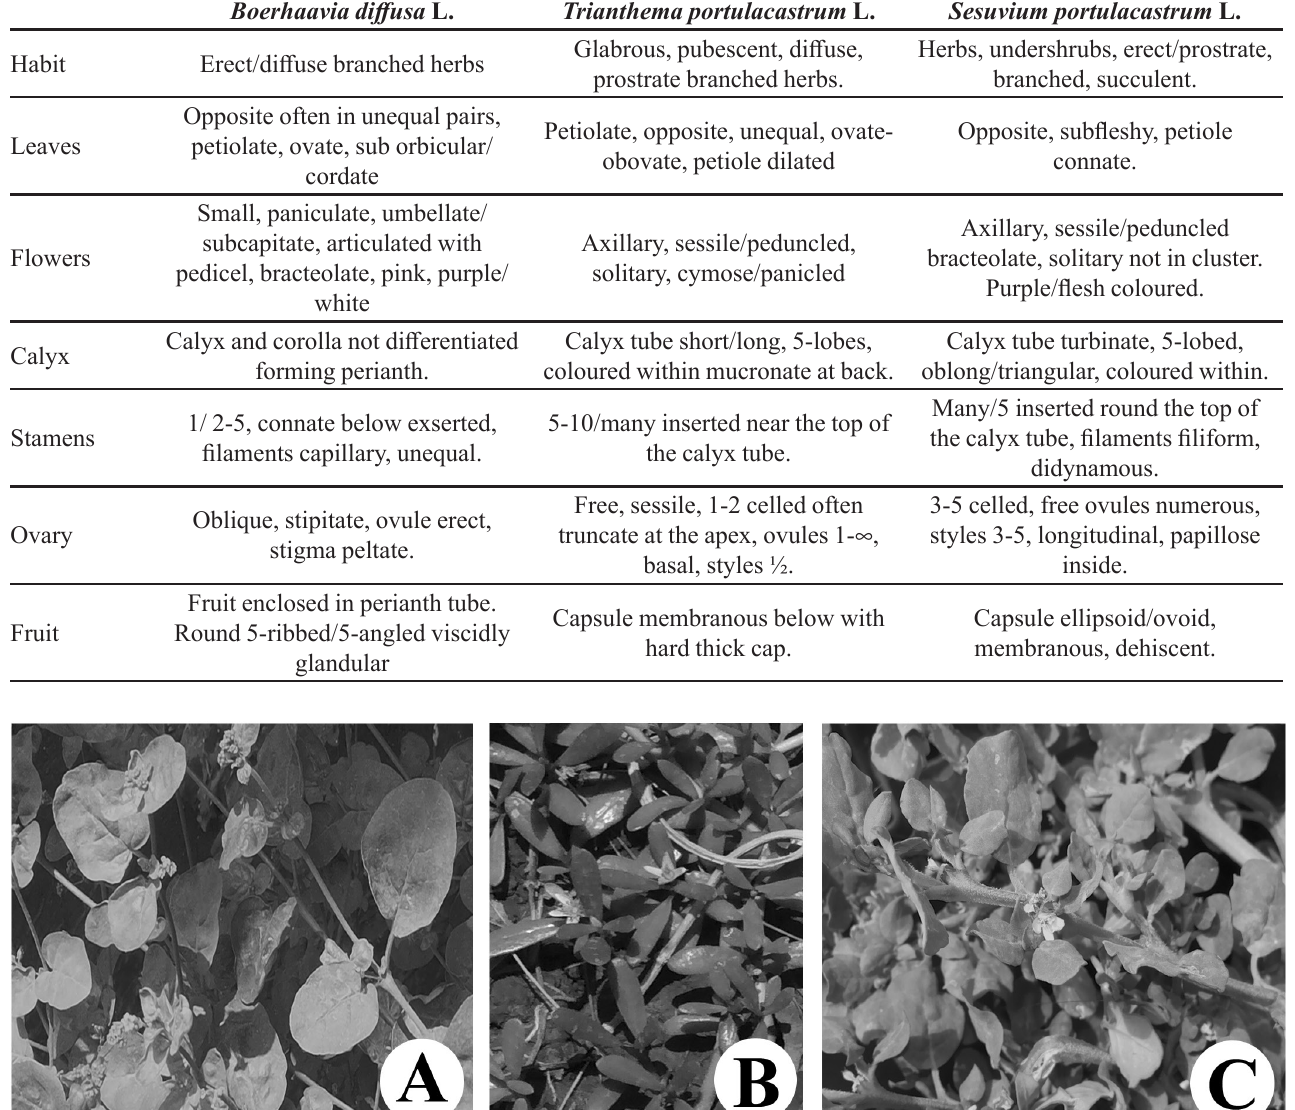
TABLE I - Boerhaavia diffusa are differentiated on the basis of following morphological characters